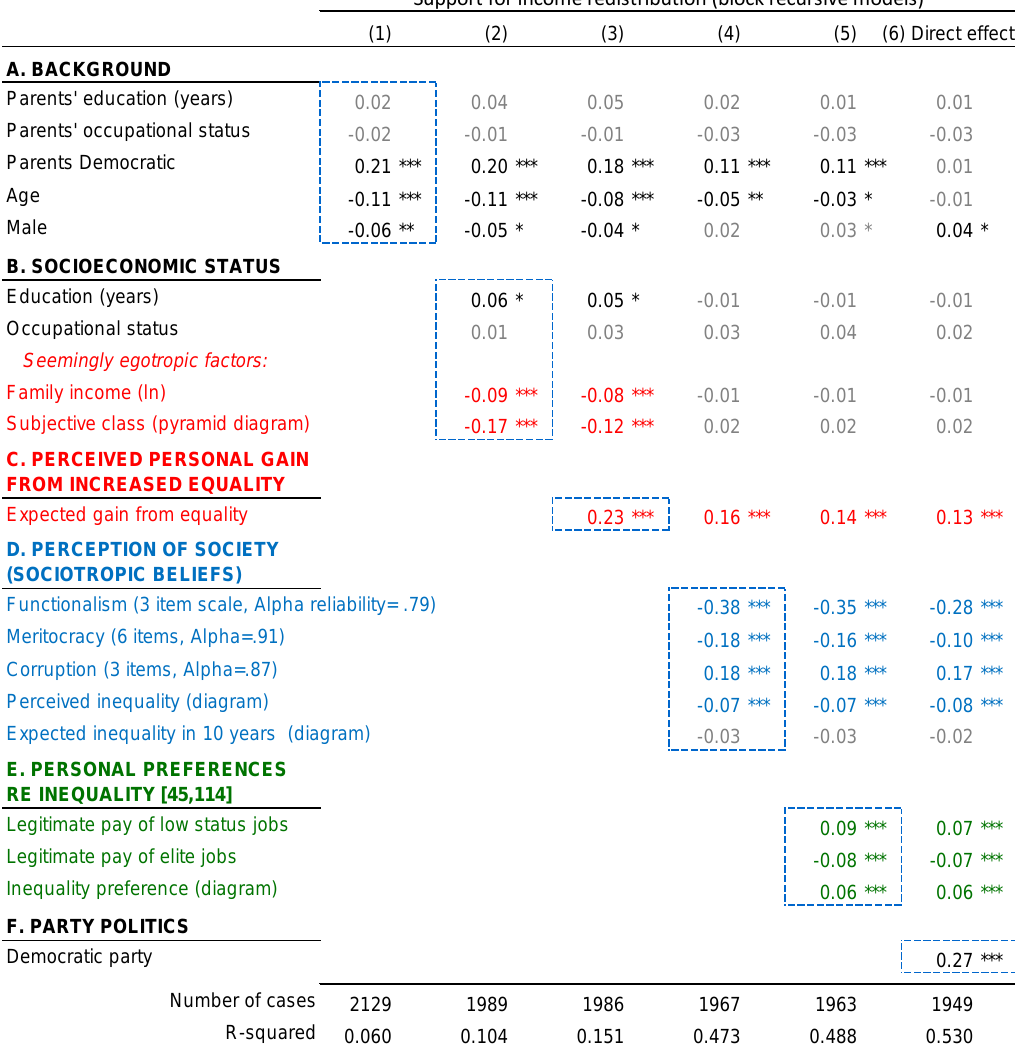
Figure 19. Influences on attitudes toward income redistribution in the United States, 2016–2017: Background, socioeconomic status, self-interest, perceptions of society, goals for society, and political party (assumed to be in that causal order). Standardized partial regression coefficients. Self-interest (egotropic) considerations in red; matters related to the general good (sociotropic influences) in blue; and personal preferences about inequality in green. Coefficients which are not statistically significant at p < 0.05 are in grey. Total effects in dashed blue outline, assuming the causal order shown; direct effects in Column 6; indirect effects are the difference between them.